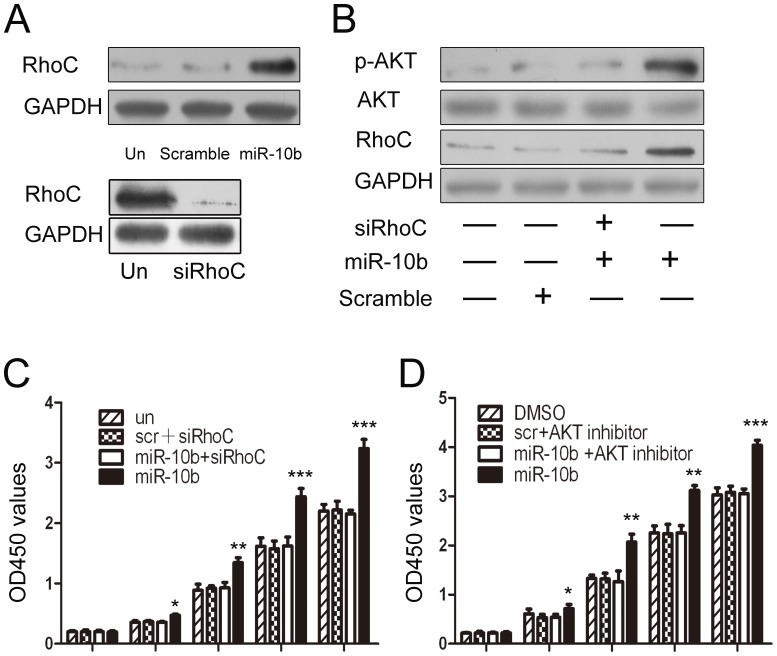
miR-10b induces cell proliferation in the AKT-dependent pathway.(A) miR-10b promotes RhoC expression. NP cells were transfected with 50 nmol/L of miR-10b mimics, sramble or not transfected. RhoC were detected by immunoblotting. SiRhoC inhibited RhoC protein expression. (B) miR-10b leads to AKT phosphorylation through RhoC. AKT, p-AKT and RhoC were detected by immunoblotting. (C) and (D) Inhibition RhoC or AKT (40 µM) repressses miR-10b-induced cell proliferation. Values are presented as mean ±SD. As compared with control, **p<0.01, *p<0.05, and **p<0.01.